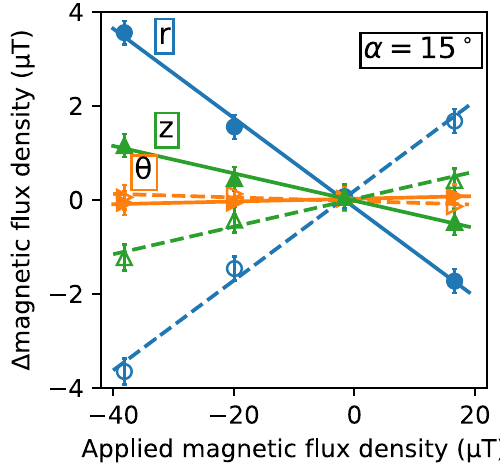
FIG. 13. Linearity of the change in the magnetic field trapping to the applied magnetic field (closed markers) and releasing case (open markers) at 15°. The solid lines denote linear regression.